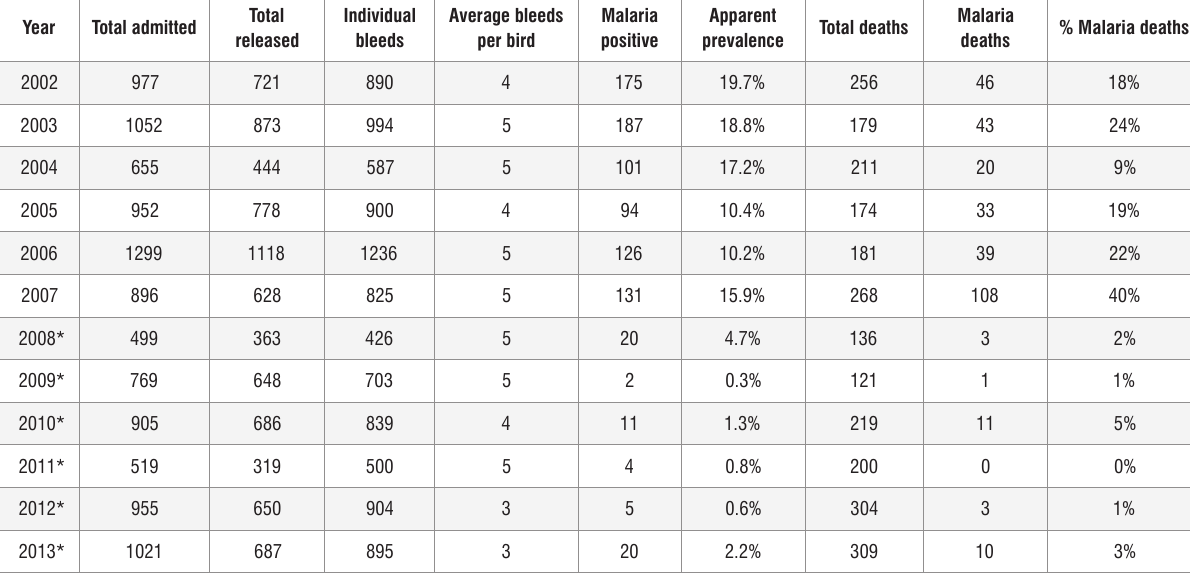
Table 3: Prevalence of avian malaria in African penguins admitted to SANCCOB for rehabilitation Year Total admitted